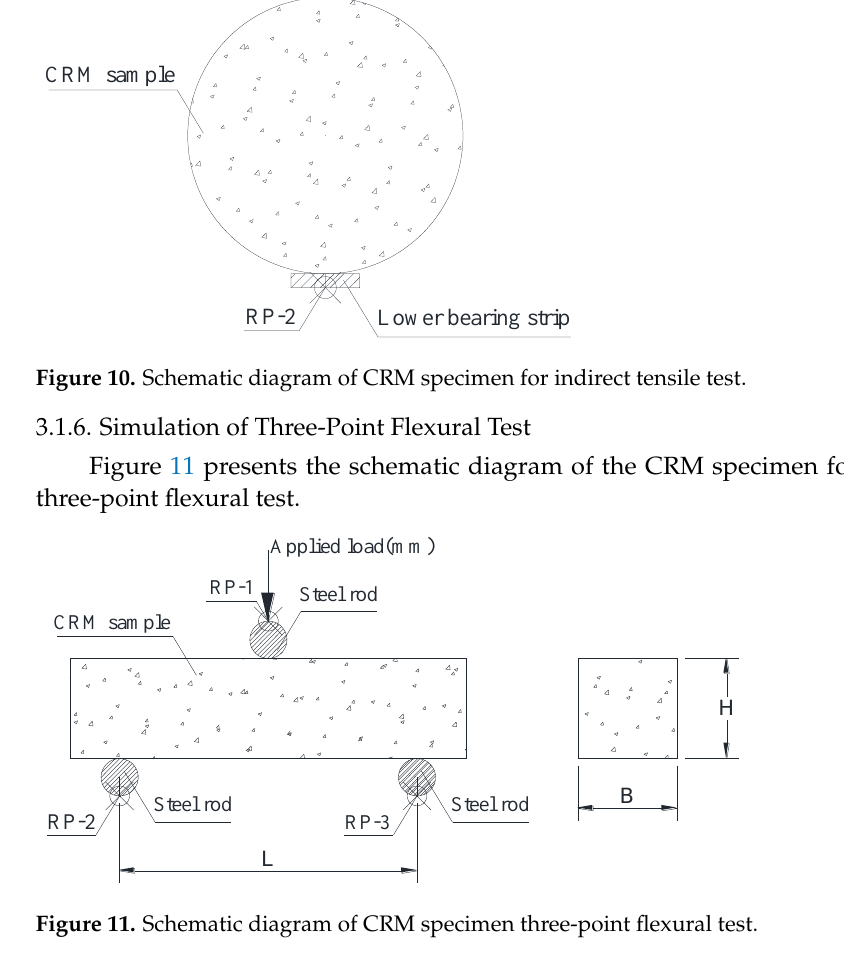
Figure 11. Schematic diagram of CRM specimen three-point flexural test.